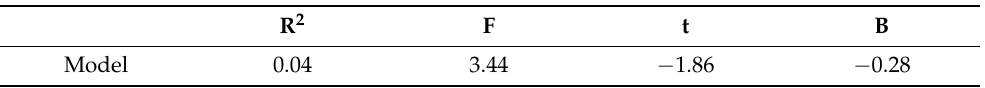
Table 3. Simple Linear Regression Analysis for Neuroticism and Trust in e-Commerce. R 2